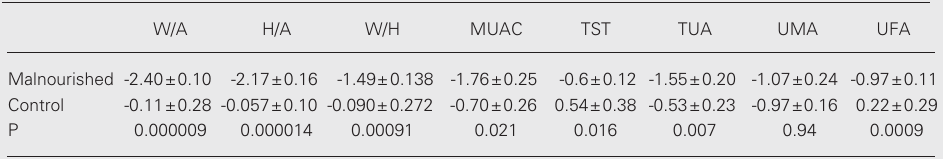
Data are reported as mean ± SEM. W/A = weight-for-age; H/A = height-for-age; W/H = weight-for-height; MUAC = mid- upper arm circumference; TST = triceps skinfold thickness; TUA = total upper arm area; UMA = upper arm muscle area; UFA = upper arm fat